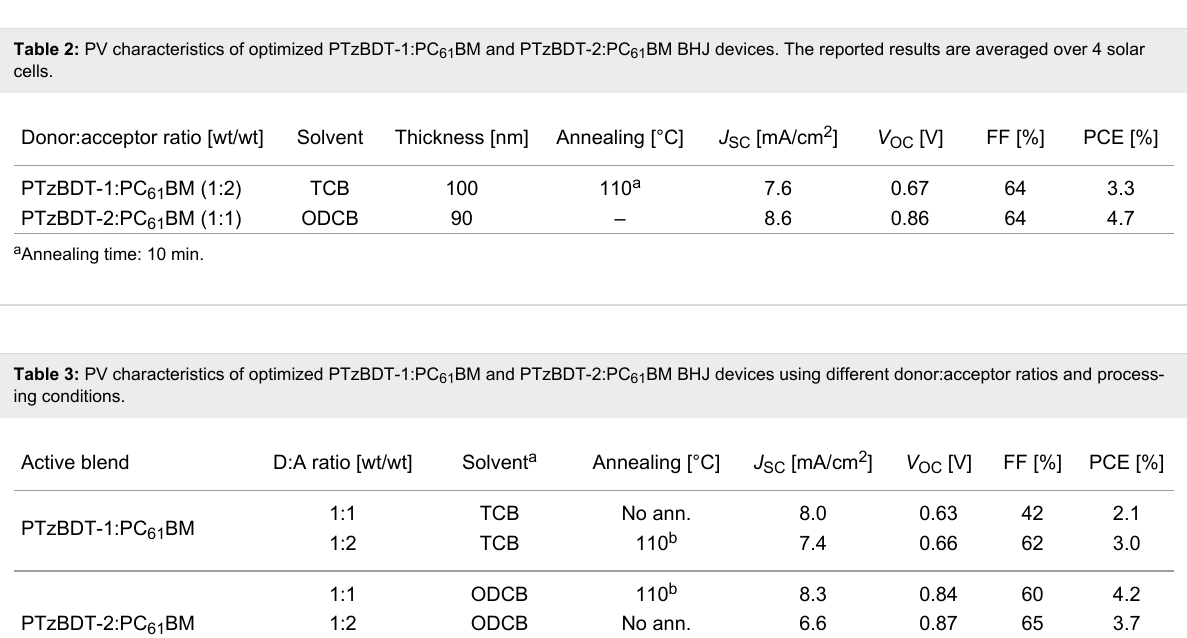
Table 2: PV characteristics of optimized PTzBDT-1:PC 61 BM and PTzBDT-2:PC 61 BM BHJ devices. The reported results are averaged over 4 solar cells.